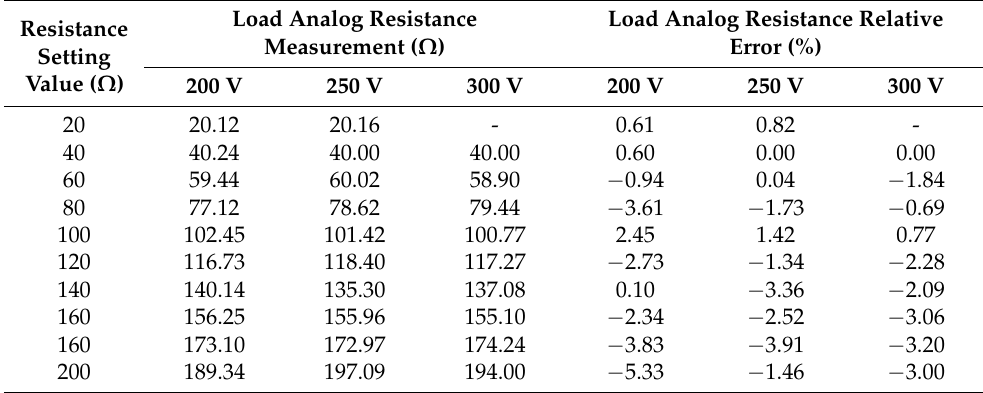
Table 5. Test results of simulation accuracy of constant resistance load.